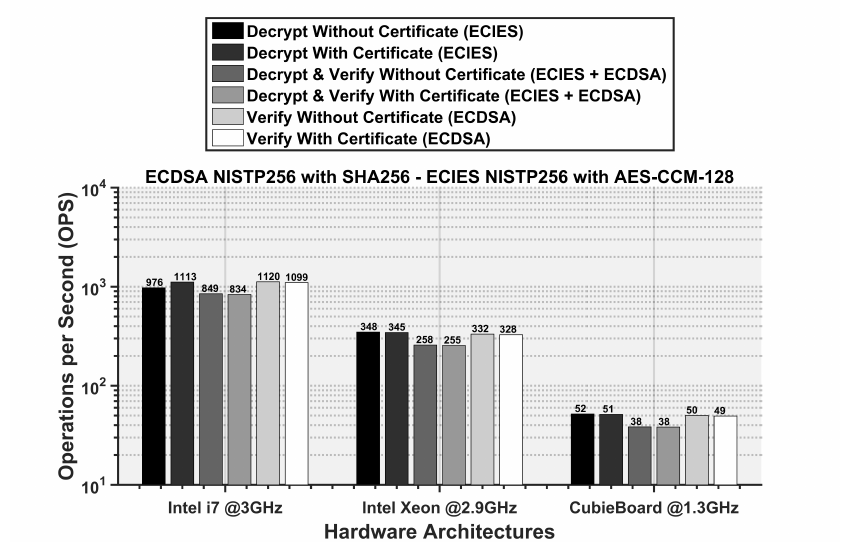
Figure 13. Required operations per second (OPS) for different DECAP procedures in conformance with the ETSI